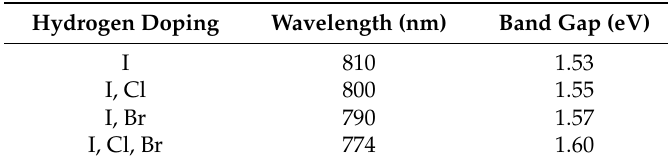
Figure 5. X ‐ ray diffraction patterns (XRDs) of FTO/TiO 2 /CH 3 NH 3 PbI 3 − x − y Br x Cl y cells: ( a ) 10° < 2 θ < 40°; and ( b ) 13.5° < 2 θ < 14.5°.